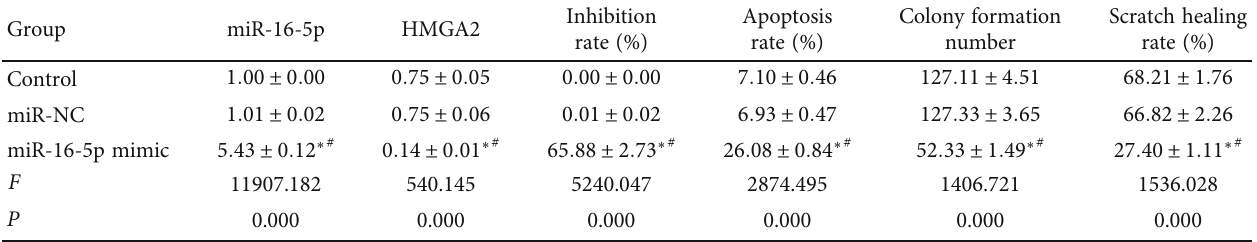
Table 2: E ff ects of overexpression of miR-16-5p on proliferation, migration, and apoptosis of DU145 ( (cid:1) x ± s , n = 9 ).